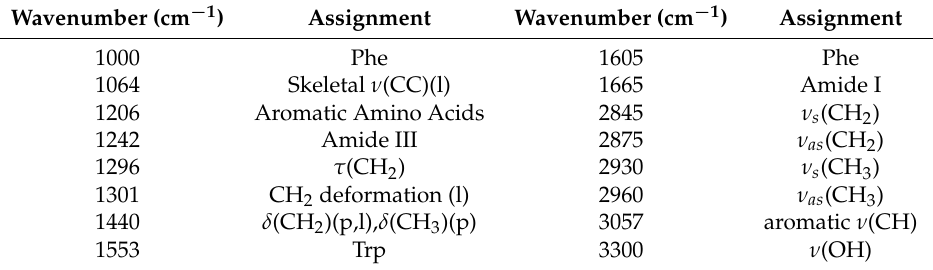
Figure 2. ( A ) Bright-field image of a tear deposit region and ( B ) Raman spectra corresponding to the points indicated in panel ( A ). The scale bar in the picture is 10 µ m. Table 2. Raman assignment of the spectral intensities in the typical tear